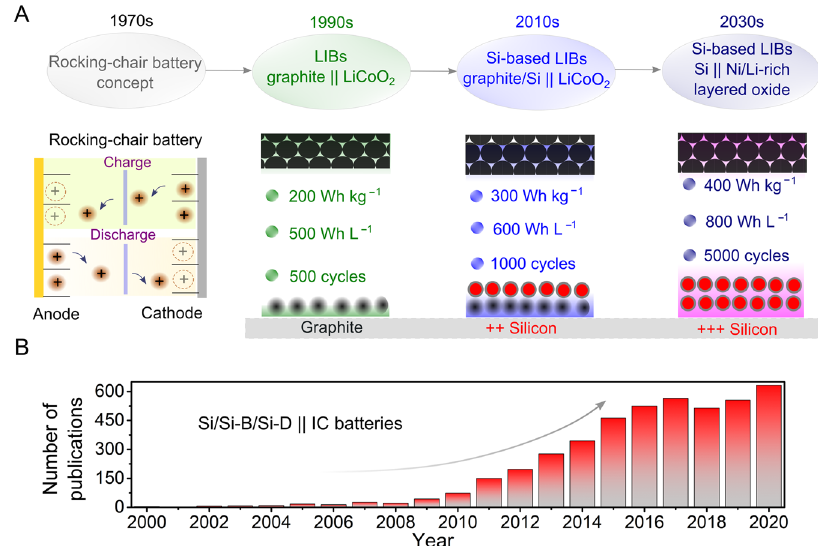
Fig. 1 Overview of the development of LIBs over the years. A Evolution of LIBs from the rocking-chair battery concept to today ’ s LIBs and next-generation Si/Si-B/Si-D||IC batteries. Key indicators (speci fi c energy, energy density and cycle life) are comparatively displayed. B Research trend in the fi eld of Si/Si- B/Si-D||IC cells. (Last updated on June 28th, 2021 at 2 pm, Berlin time). The key search words used in Scopus ® were ‘ lithium-ion battery + silicon anode/ Si-based/derivatives + insertion and/or intercalation cathode ’